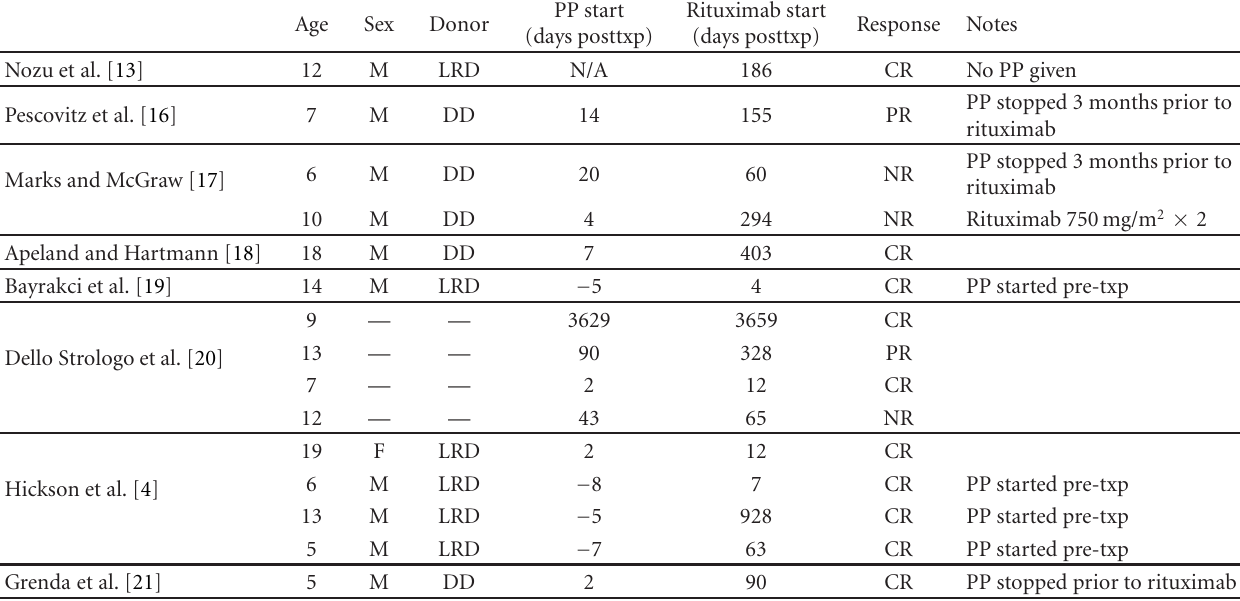
Table 2: Summary of the literature on use of rituximab in pediatric recurrent